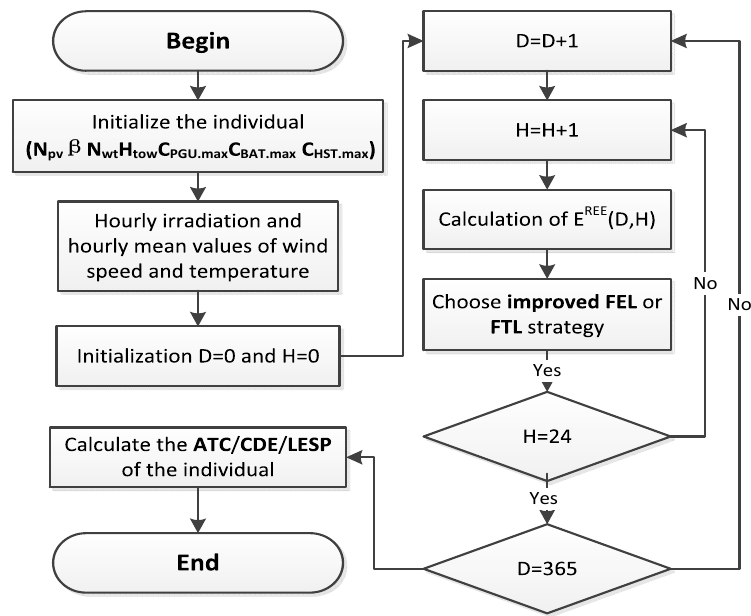
Figure 7. Flowchart of system simulation. ATC: annual total cost; CDE: carbon dioxide emission; LESP: loss of energy supply